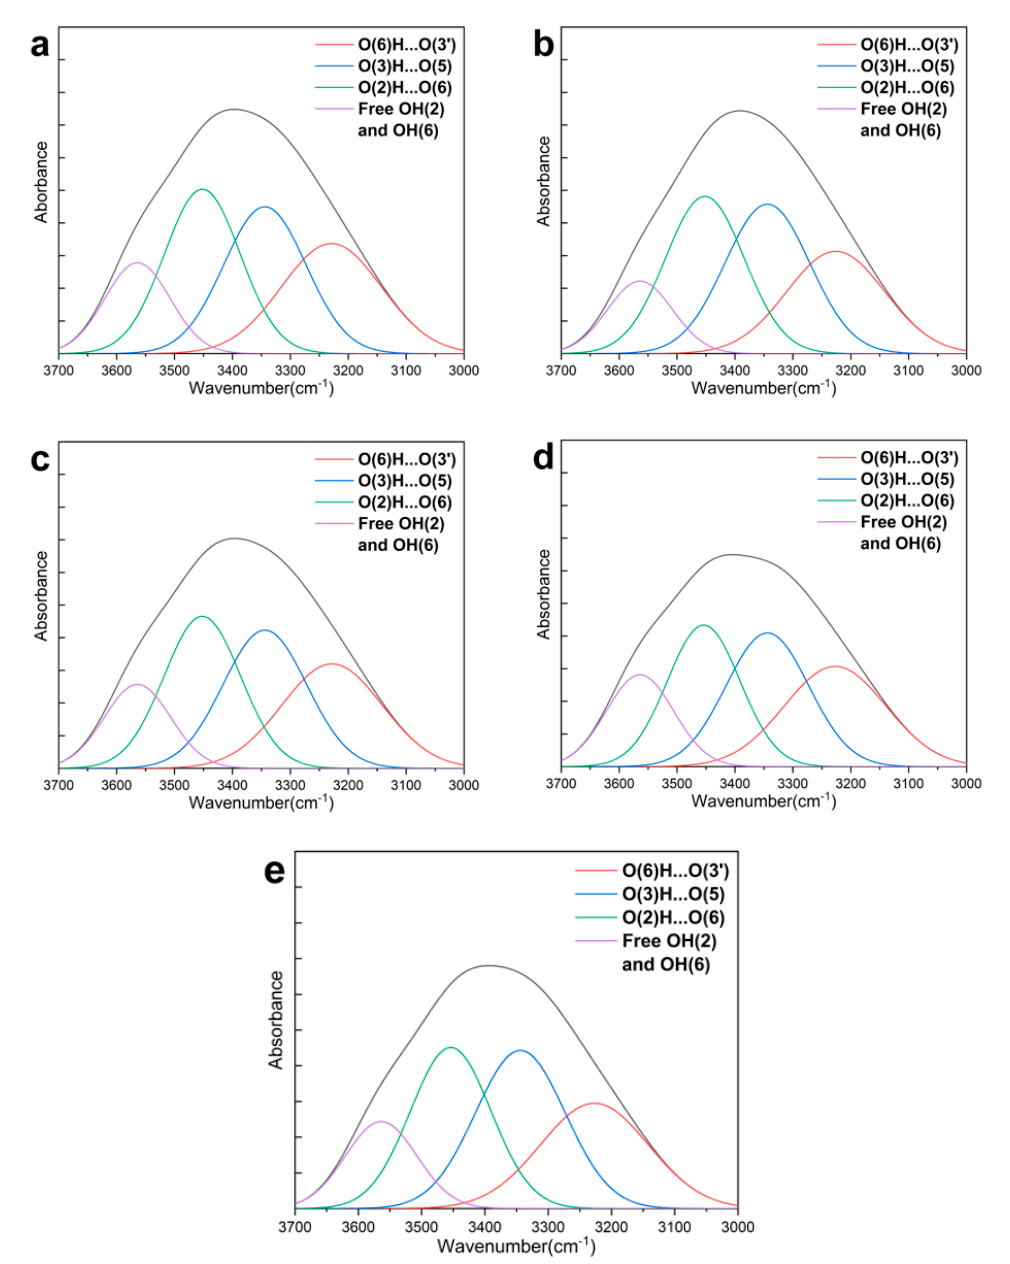
Figure 7. The deconvoluted FT-IR spectra of softwood fibers at various revolutions: ( a ) 0 r, ( b ) 4000 r, ( c ) 8000 r, ( d ) 12,000 r, and ( e ) 16,000 r.